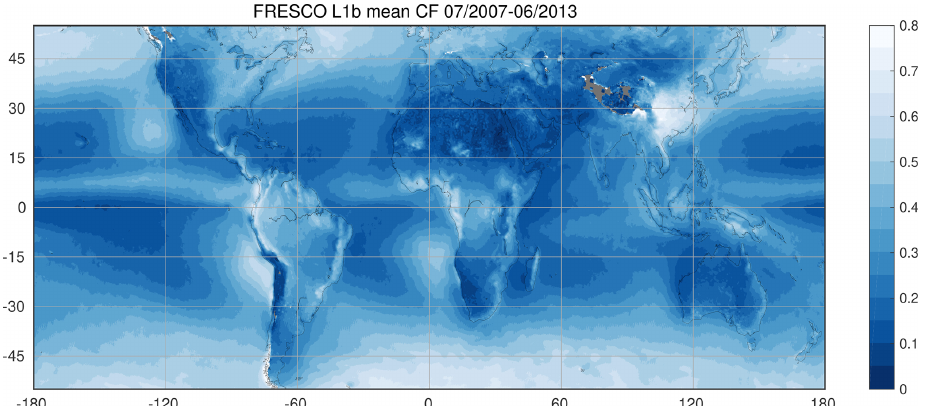
Figure F4. Same as Fig. 14 but showing the 6-year average of the FRESCO L1b cloud fraction measurements recorded between 1 July 2007 and 30 June 2013. Areas without data are plotted in gray.